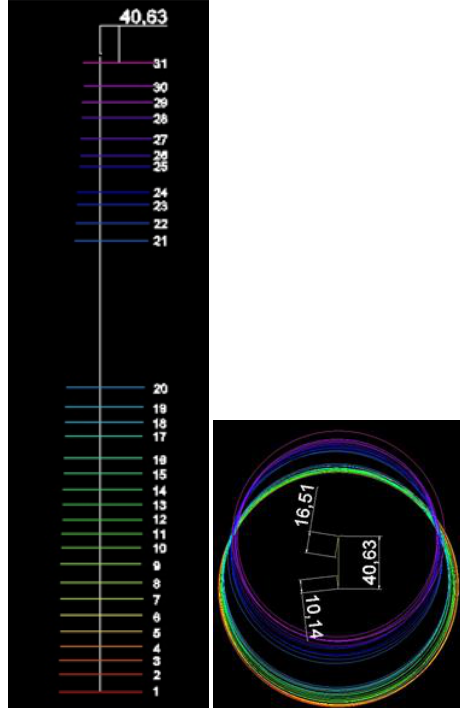
Figure 9. Deviations in the vertical direction for whole